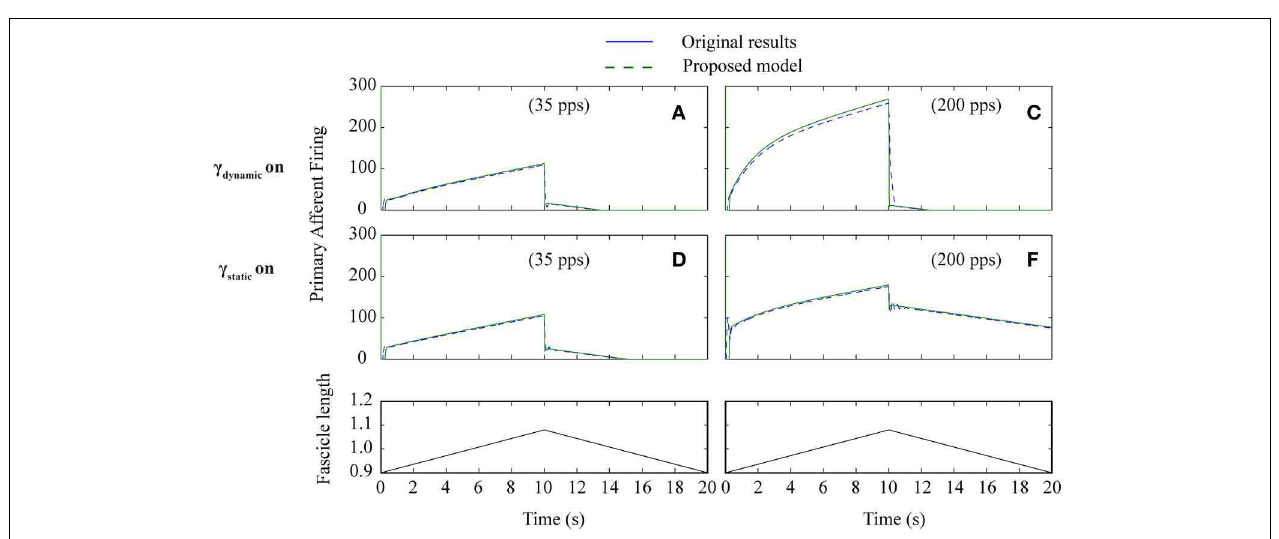
FIGURE 5 | Proposed spindle model compared to original results from paper Mileusnic et al. (2006a) for two triangular stretches with different levels of fusimotor activity. Results are from Figure 3: A–L